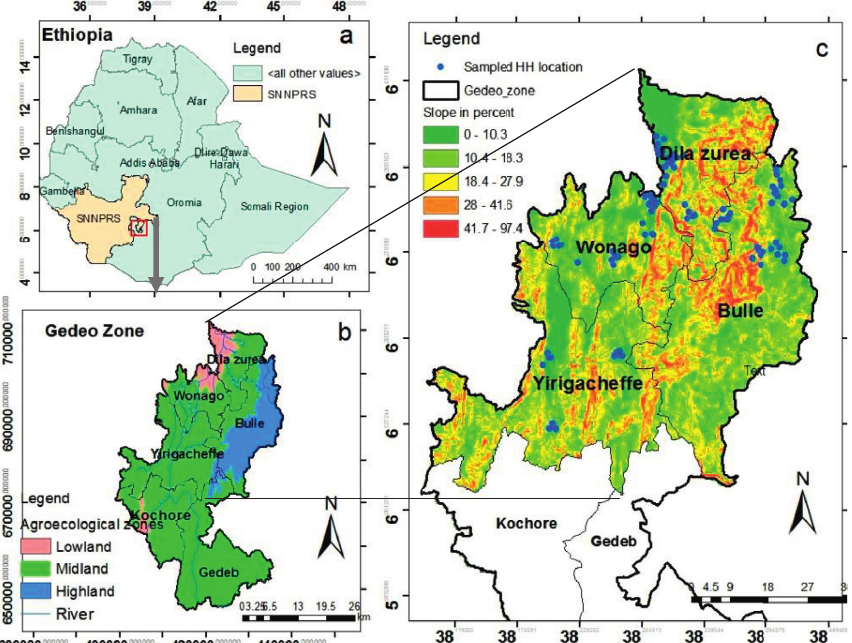
Figure 1: Map of the study area. (a) Location of SNNPRS in Ethiopia and location of Gedeo zone in SNNPRS, (b) district in Gedeo zone and agroecological zone classification, and (c) slop of sampled districts and location of sampled households. Table 1: Socioeconomic indicator of wealth class in the study area.